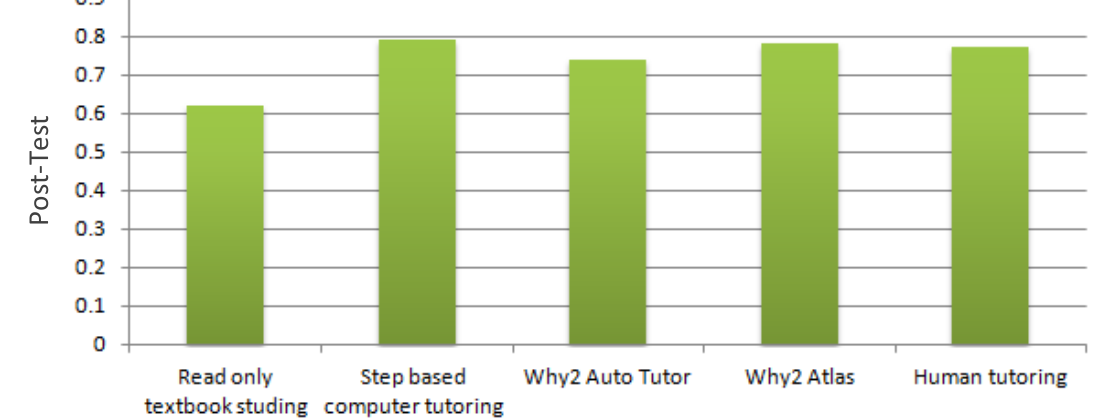
Figure 3. Different type of ITS